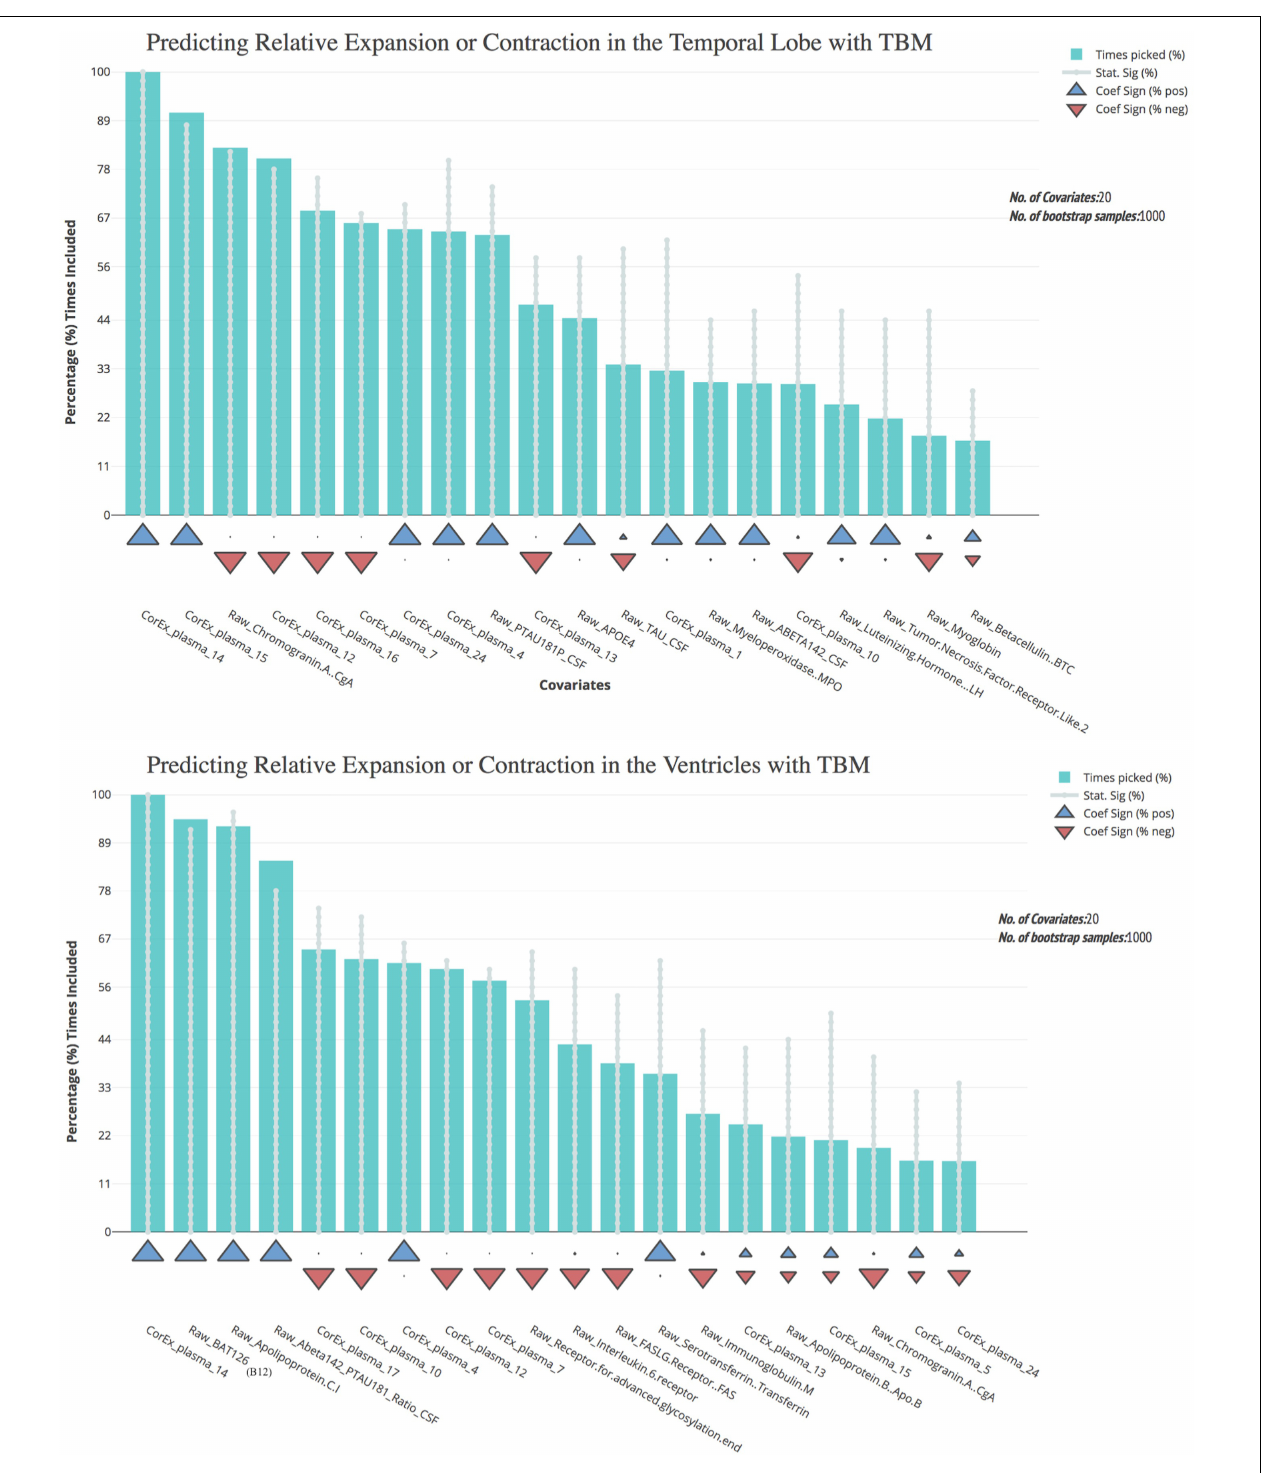
FIGURE 5 | Bootstrap regression results for atrophy measures using tensor-based morphometry in the temporal lobes (top) and ventricles (bottom) . As outlined in the Methods, we computed tensor-based morphometry (TBM) measures of atrophy between baseline scanning and 1-year follow-up. To understand the most predictive features of these atrophy measures, we performed feature selection using CorEx plasma and the original plasma measures, and then ran bootstrap stepwise regressions using 1,000 permutations for each TBM measure. The top features are shown on the left; arrows indicate the direction of effect for each measure. A prefix of “Raw” and “Brain” are used to denote the original measures, while “CorEx” indicates the transformed factors identified using CorEx. Corresponding regions included in the CorEx factors are outlined in Figures 2, 3 .